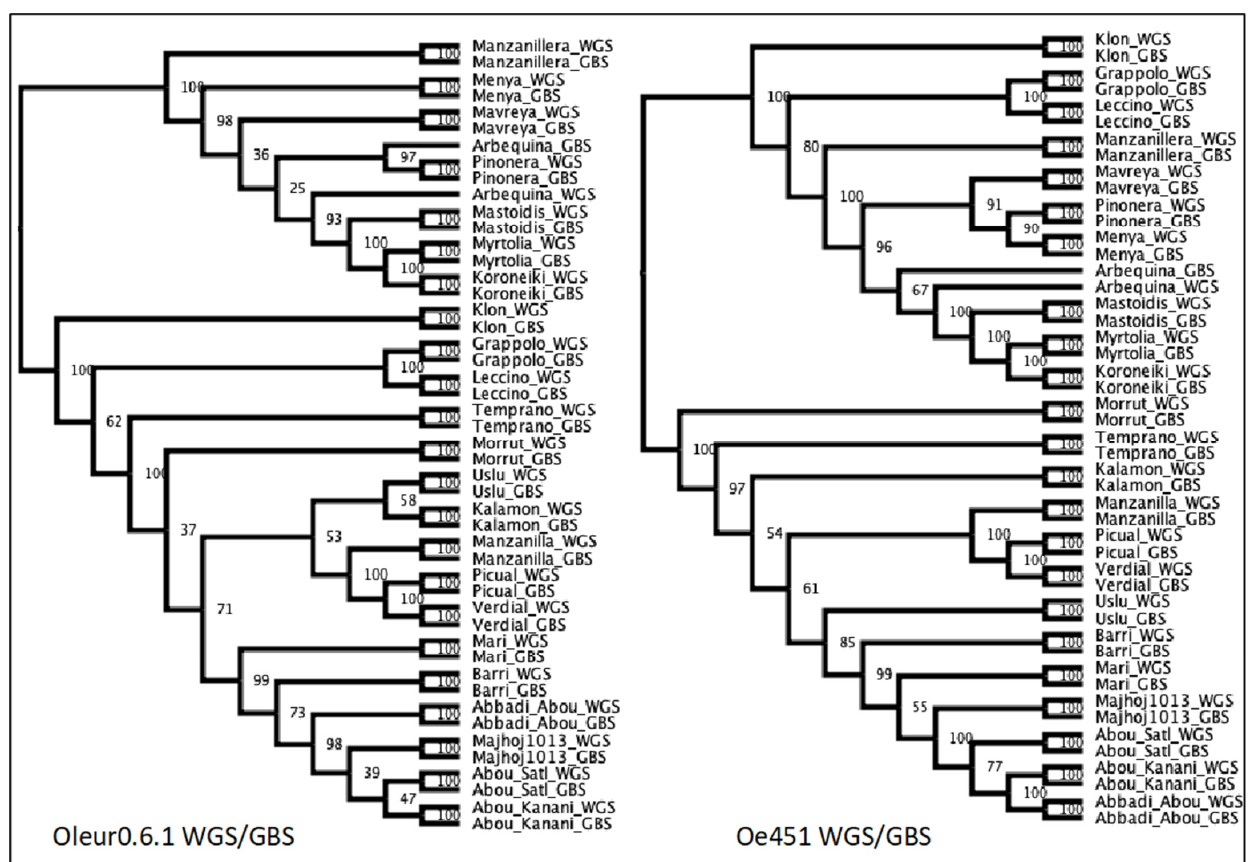
Figure 2. PCA clustering of WGS/GBS datasets. This shows the clustering of WGS and GBS merged samples. Principle components 1 and 2 are shown for each. ( a ) PCA of merged data with reference genome Oe451; ( b ) PCA of merged data with reference genome Oleur0.6.1.